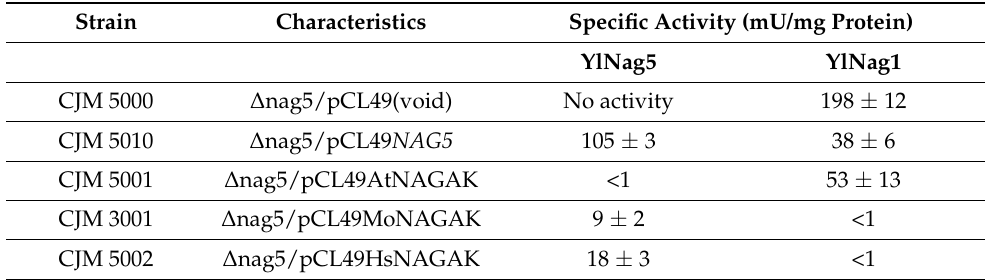
Table 1. Effects of expression of heterologous NAGA kinases on the derepression of NAG genes.